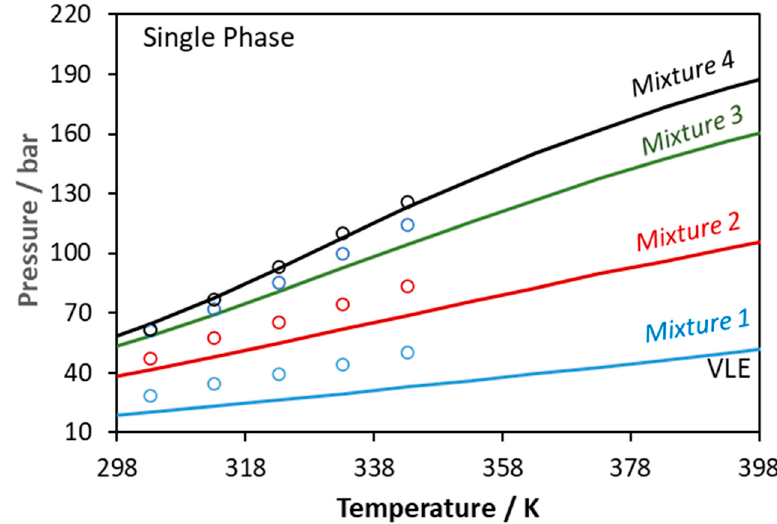
Figure 10. Phase boundaries for CO 2 –glycerol–ethanol ternary system. Experimental data (points, [56]) and CPA predictions using the binary interaction parameters of Table 6 (Mixture 1: x CO2 = 0.1333, x glycerol = 0.0413, x ethanol = 0.8254; Mixture 2: x CO2 = 0.2808, x glycerol = 0.0342, x ethanol = 0.6850; Mixture 3: x CO2 = 0.4276, x glycerol = 0.0273, x ethanol = 0.5451; Mixture 4: x CO2 = 0.4985, x glycerol = 0.0239, x ethanol = 0.4776).